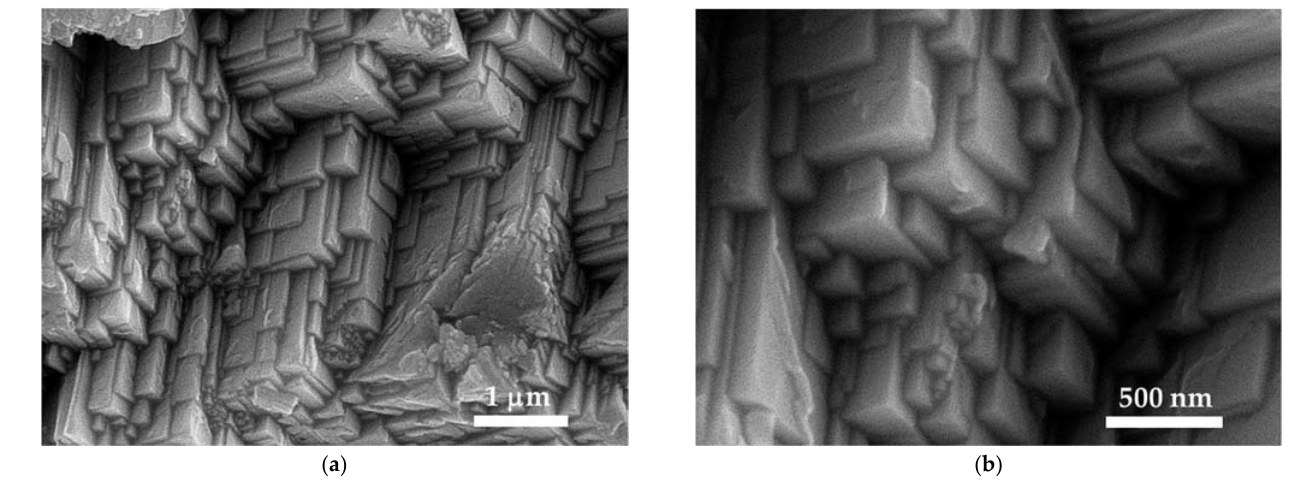
Figure 5. The scanning electron microscopy (SEM) of [Cu(12 ‐ crown ‐ 4) 2 ]I 5 ( a ) 1 μ m; ( b ) 500 nm.